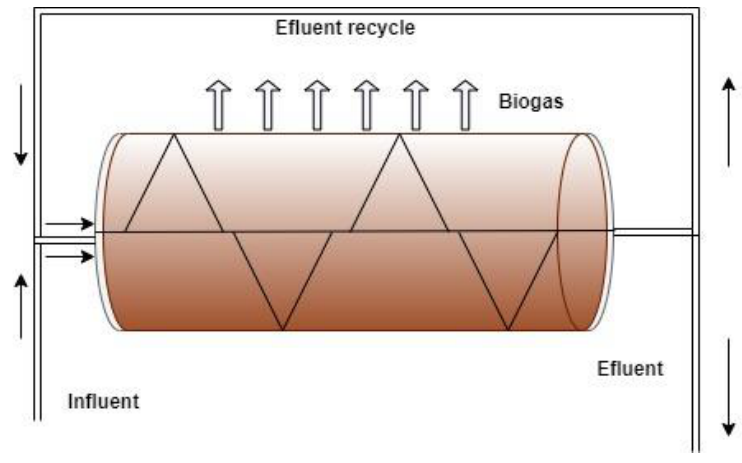
Figure 6. The reactor that provides the Kompogas process.